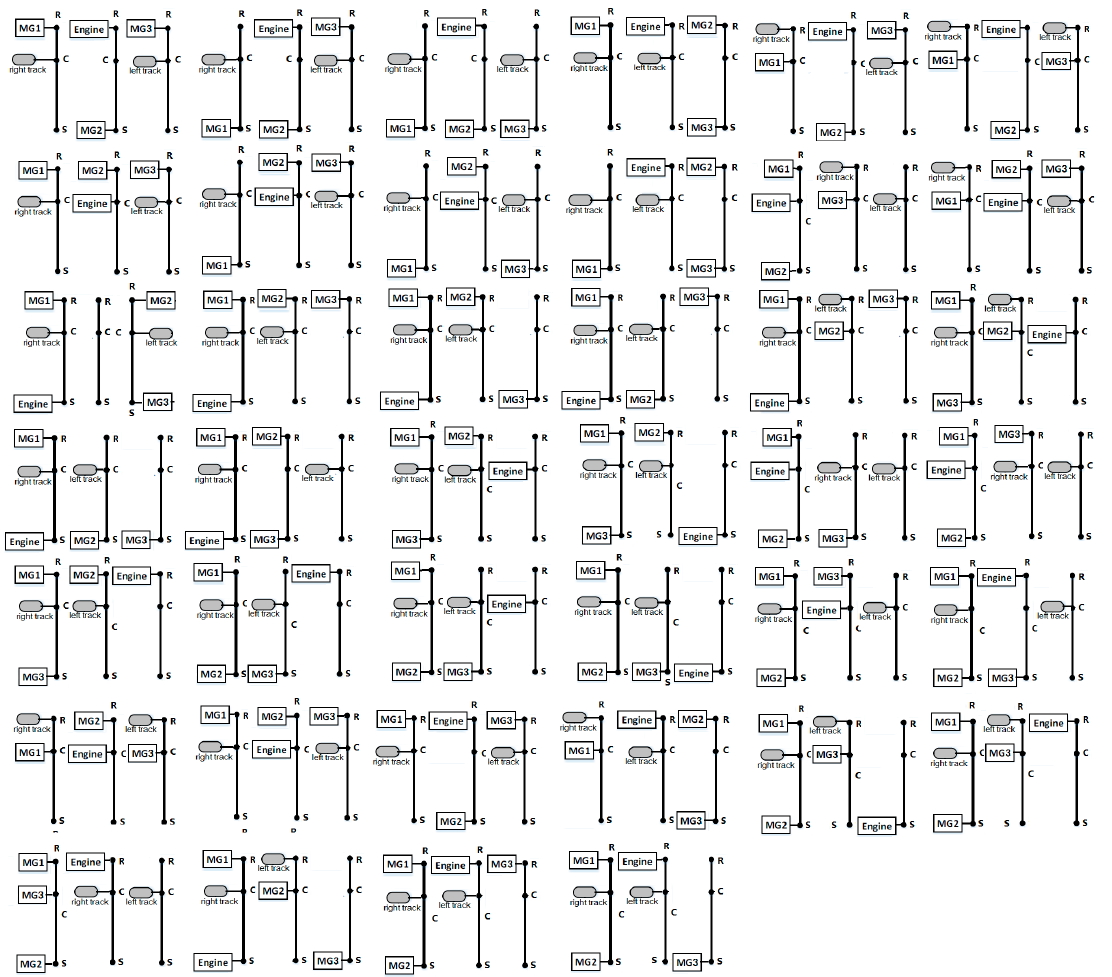
Figure 7. Forty superior configurations after speed and torque analysis.